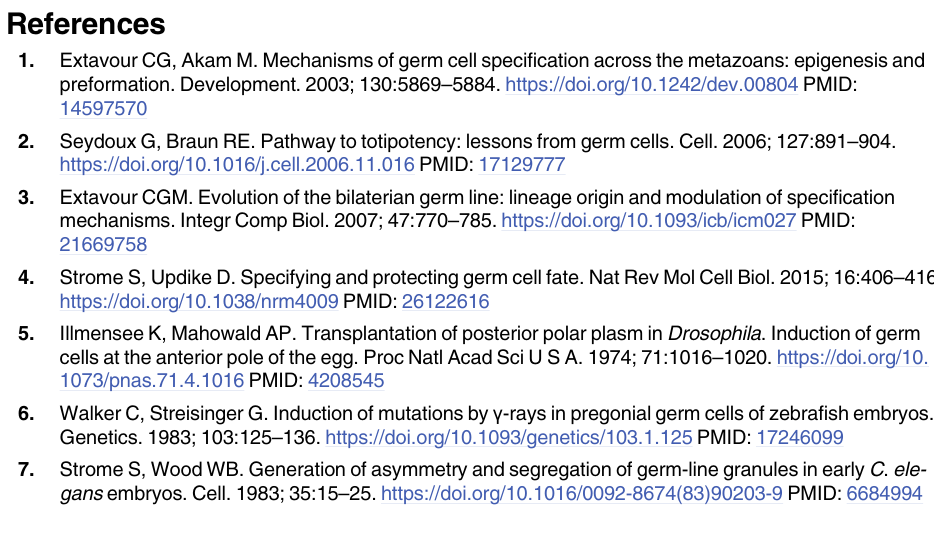
S1 Table. Information for transcripts mentioned in this paper. S2 Table. Quantitative PCR